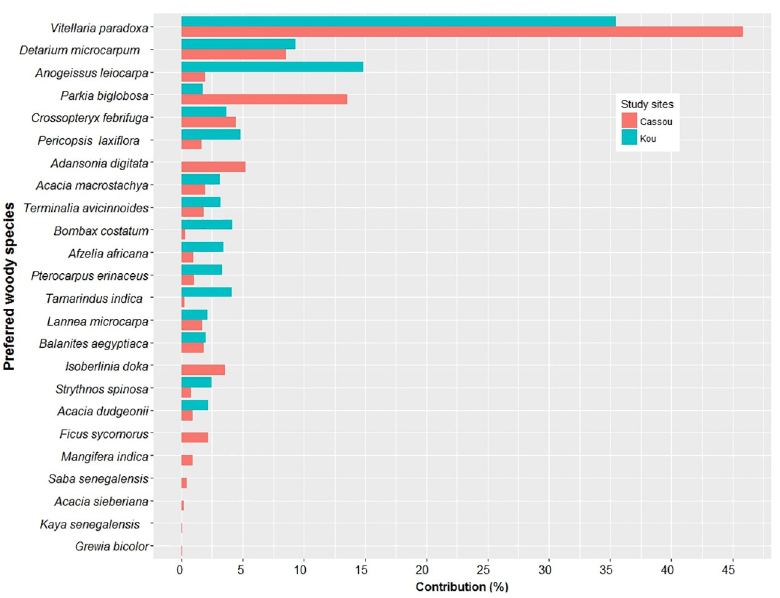
Fig 6. Contribution of preferred woody species to the pool of carbon stock in Cassou and Kou in Ziro Province of Burkina Faso.